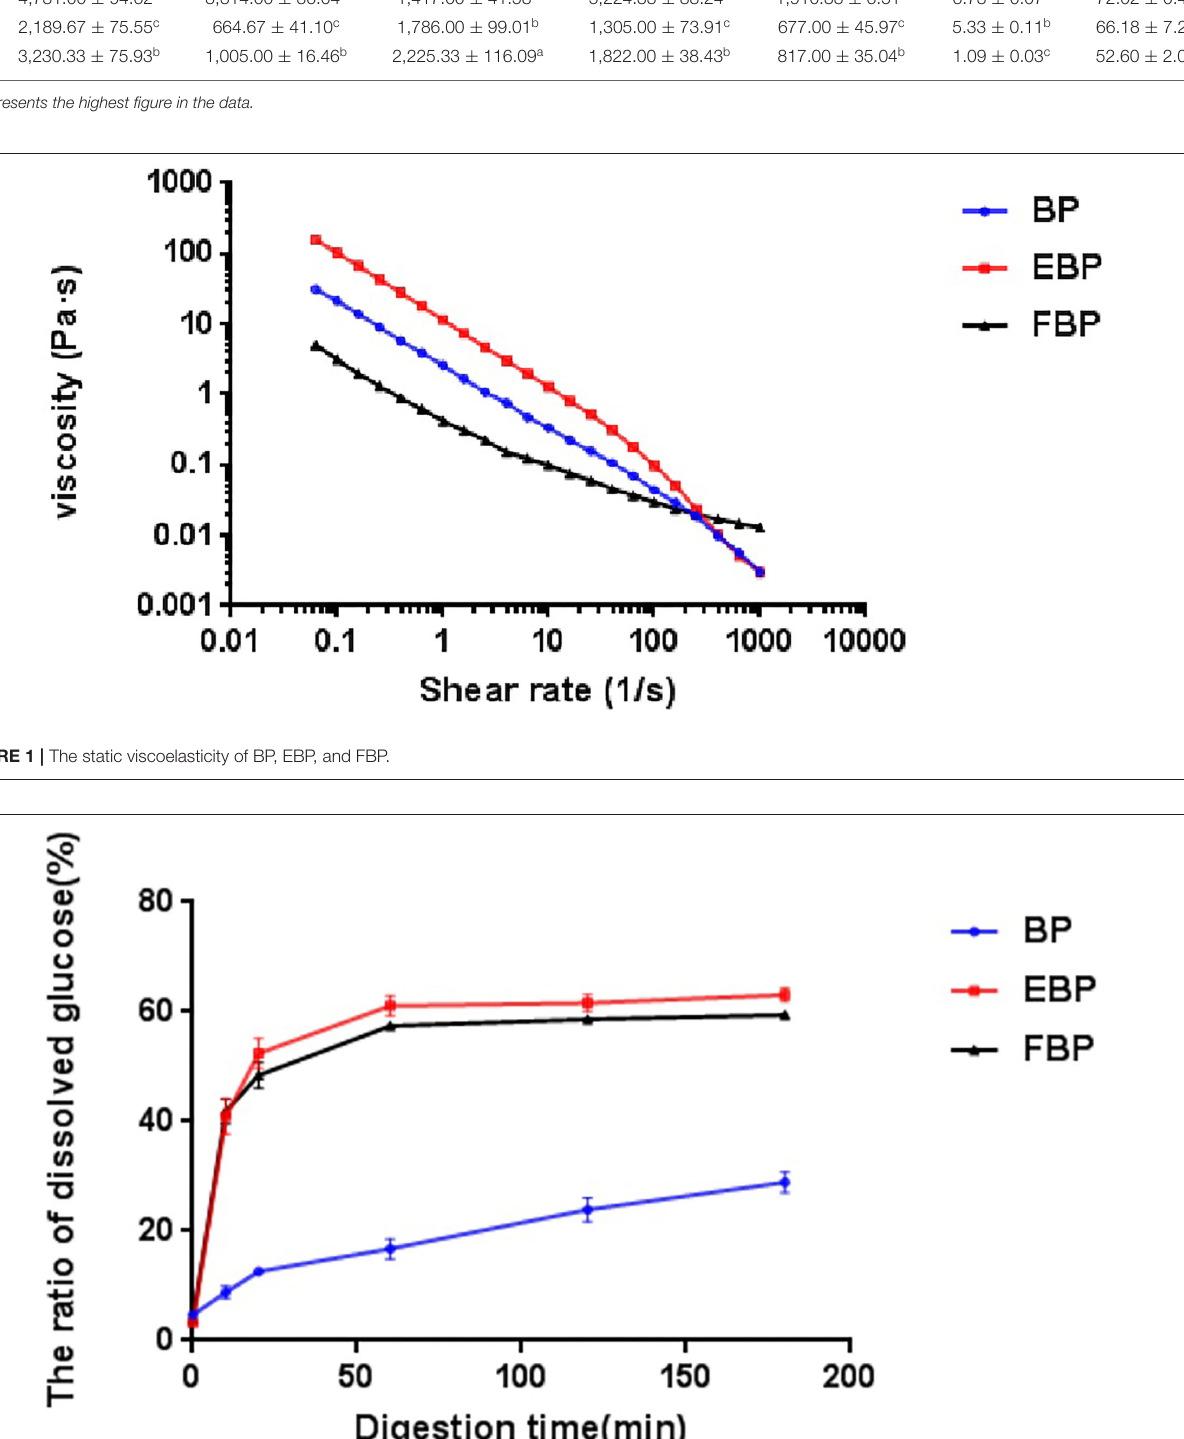
Frontiers in Nutrition |